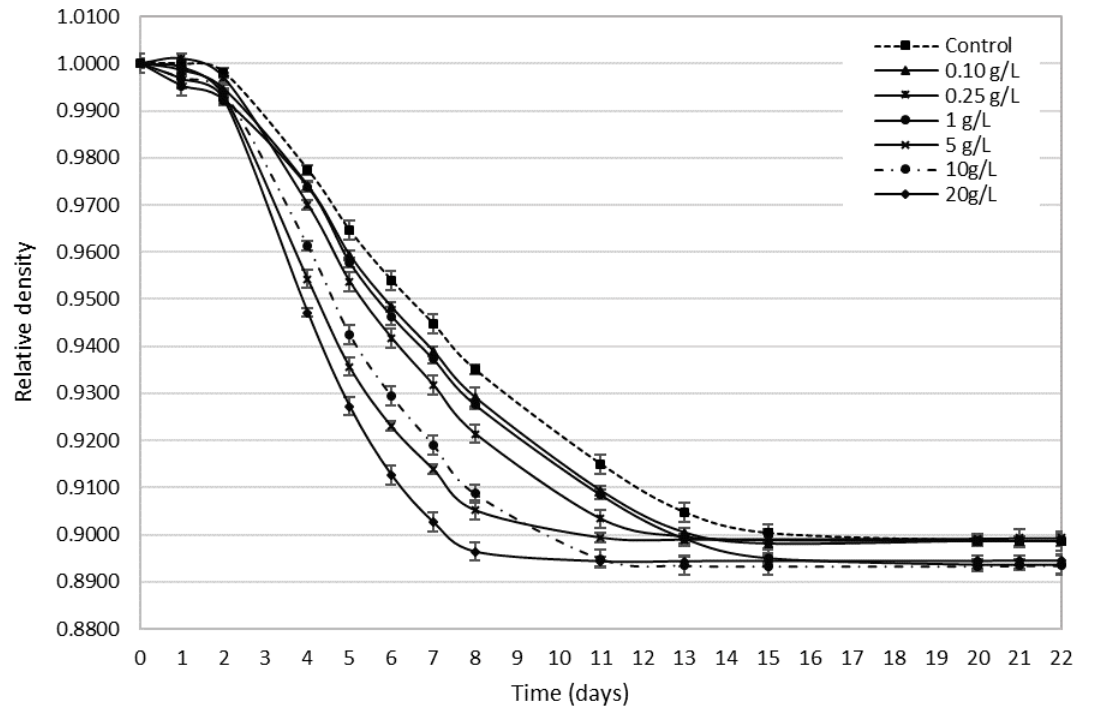
Figure 2. Relative density evolution during alcoholic fermentation of Tintilla de Rota grape-must with different pollen doses.